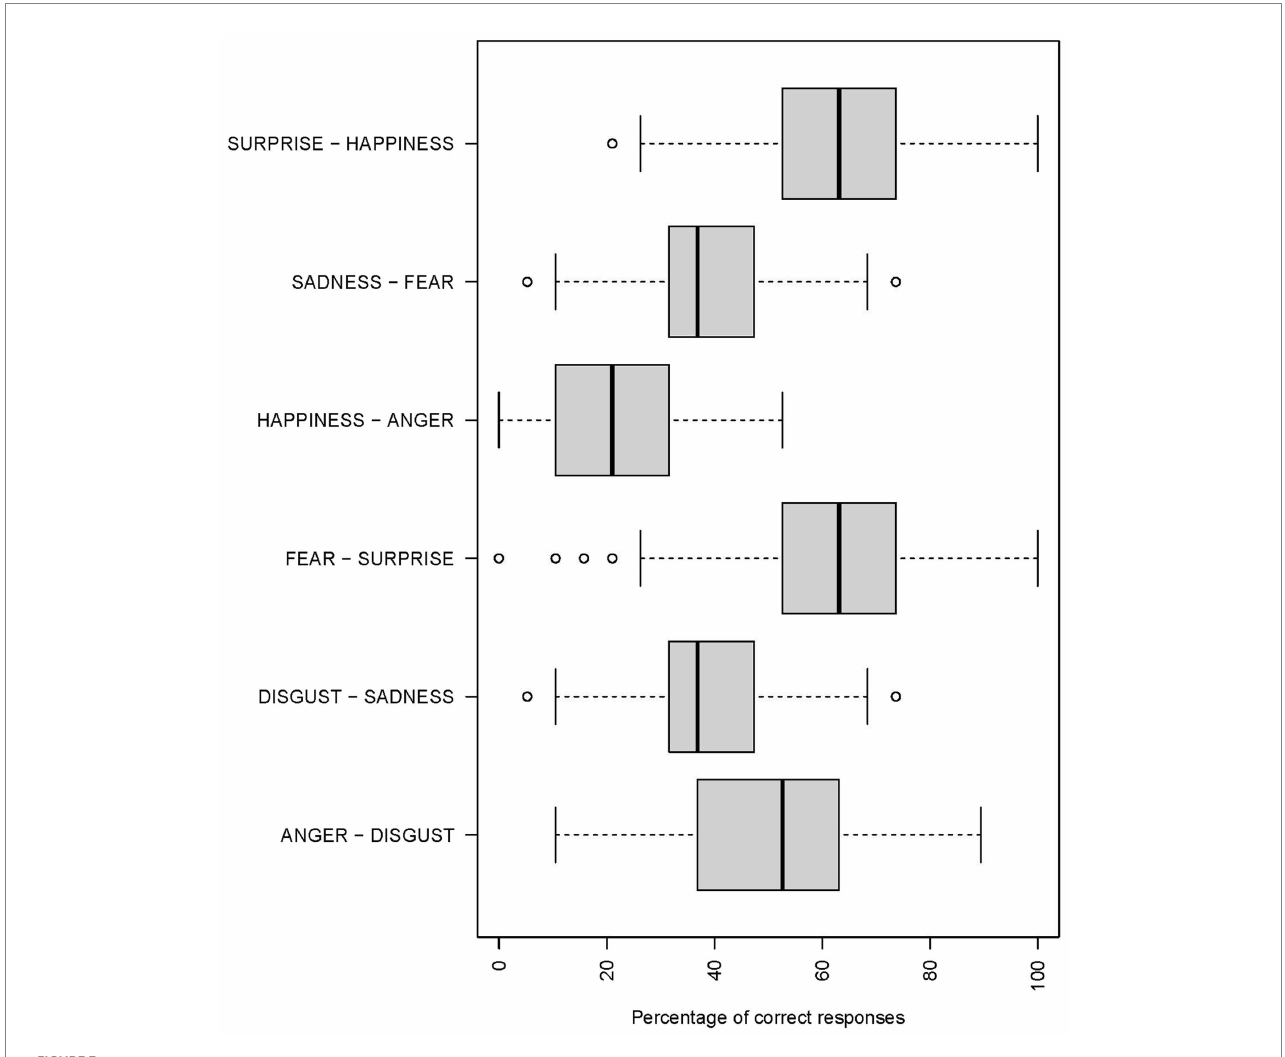
FIGURE 3 Percentage of correct responses as a function of emotions